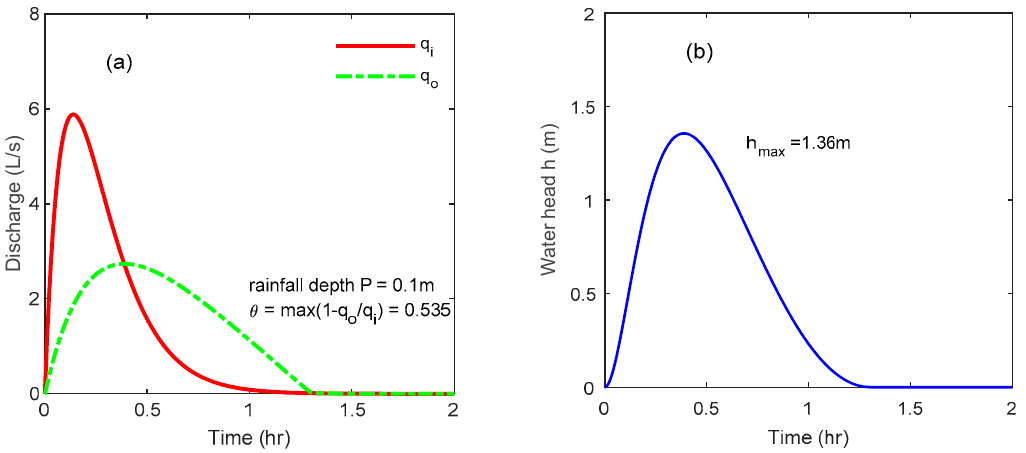
Figure 5. The discharge and water head of the buffer tank during heavy rain. ( a ) Discharge flow; ( b ) water head in the tank.